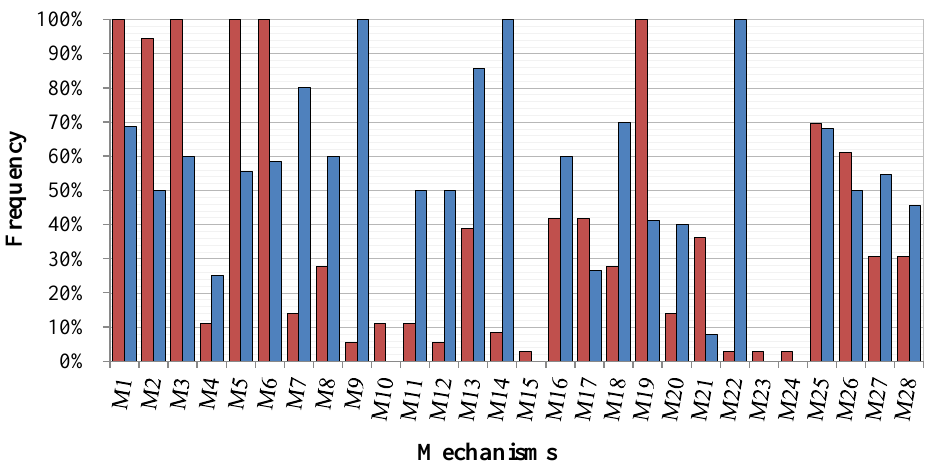
Figure 21. Presence and activation of the 28 mechanisms in the inspected churches.